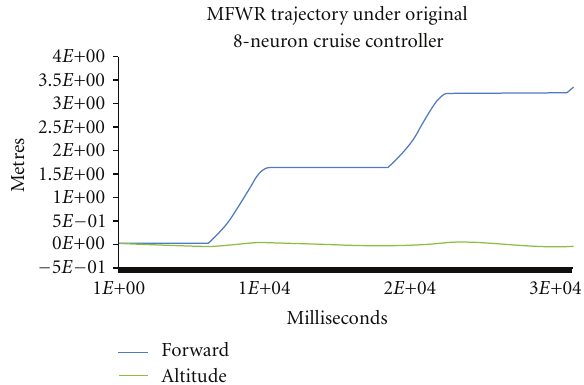
Figure 13: The MFWR trajectory produced by the original fully connected eight-neuron controller. It can be observed that the evolved controller was successful in producing forward motion in the MFWR without any overall gain in the altitude.